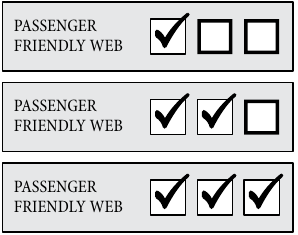
Fig. 8. Proposal of logo for ‘Passenger Friendly Web’ of 3rd–1st Class categories